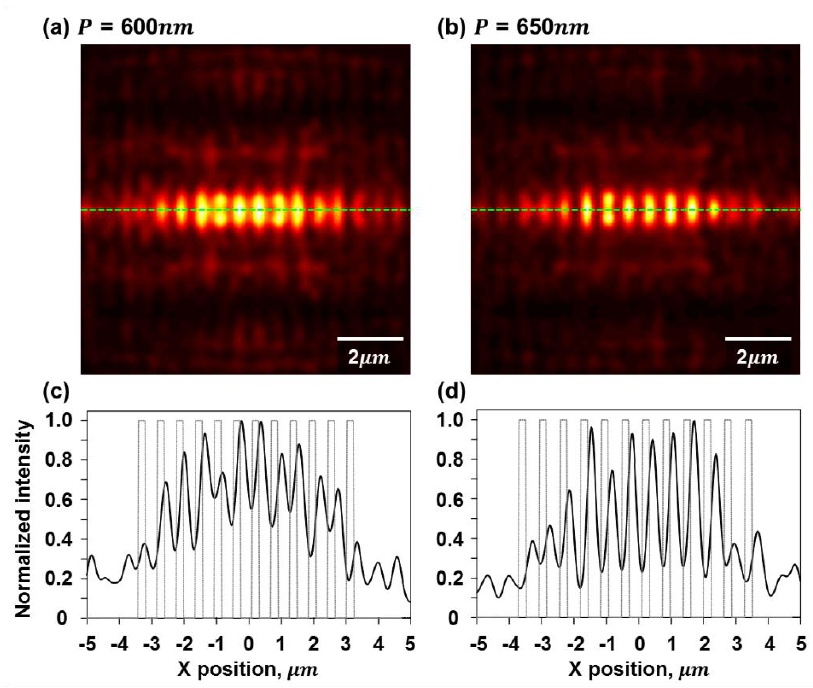
Figure 10. Imaging of grating structures with different periods. A 20-fold symmetry quasi-periodic nanohole array is used for the imaging of grating structures with different periods P. The grating structures consist of 12 nanoslits whose width is w = 200 nm and length is l = 1.5 μm. In the calculations, the periods of adjacent nanoslits are 600 nm and 650 nm, indicating the overall areas of the two designed gratings are 5.7 × 1.5 μm 2 and 6.15 × 1.5 μm 2 . By positioning the gratings on an object plane at Z obj = 13.5 μm, optimum imaged patterns are revealed on an image plane at Z img = 13.5 μm as shown in plates ( a ) and ( b ), respectively. ( c ) and ( d ) indicate the corresponding cross-section profiles as plotted in ( a ) and ( b